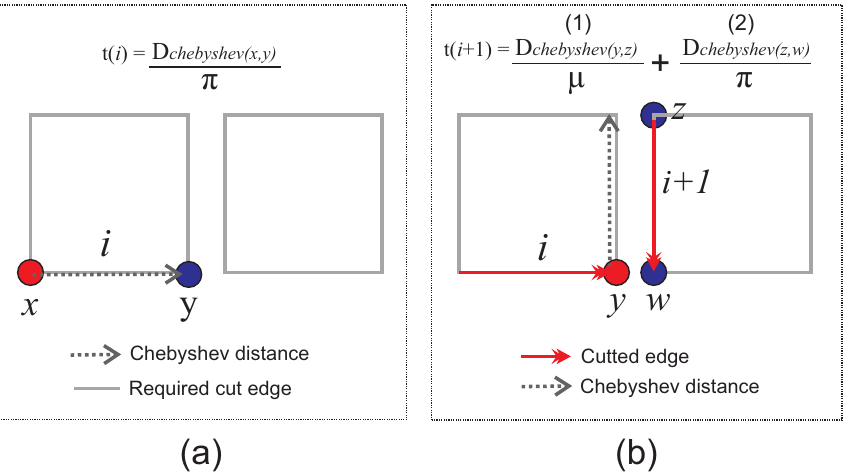
Figure 7. Fitness representation to t ( i ) and t ( i+1 ). ( a ) illustrates the i -step to compute the fitness value for each individual. ( b ) supposed that the chrom ( i + 1 ) was the edge ( z,w ) and that its direction position ( chrom ( 2 n + ( i + 1 )) ) had value